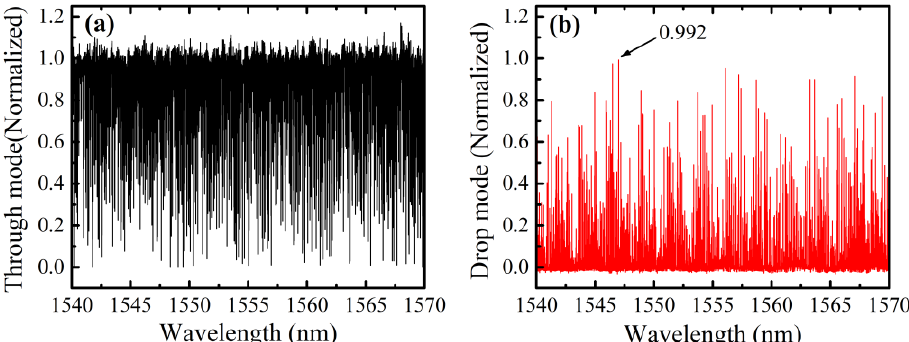
Figure 2. a , b are the transmission spectra of the through mode and drop mode in the wavelength range of 1540 nm to 1570